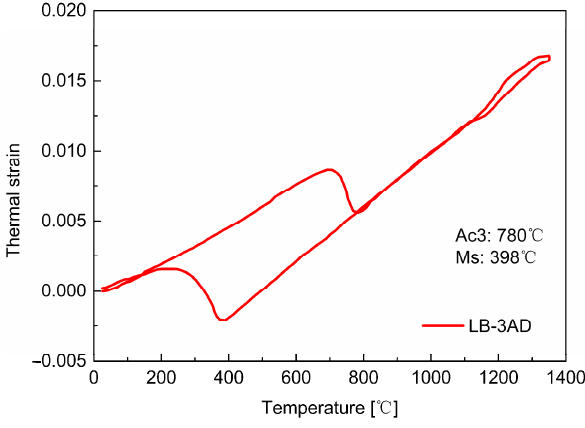
Figure 6. Dilatometric results of the LTT weld metal.